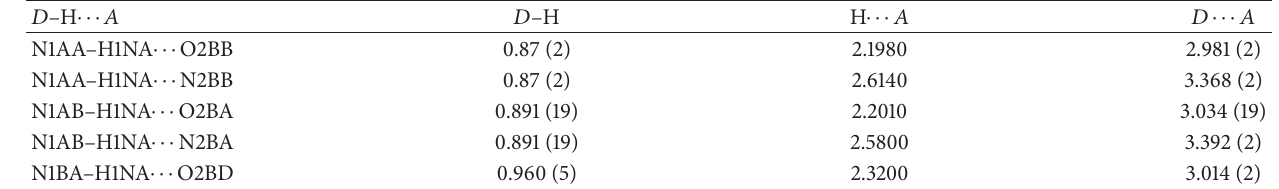
Table 3: Hydrogen-bond geometry (˚A, ∘ ) of compound 2